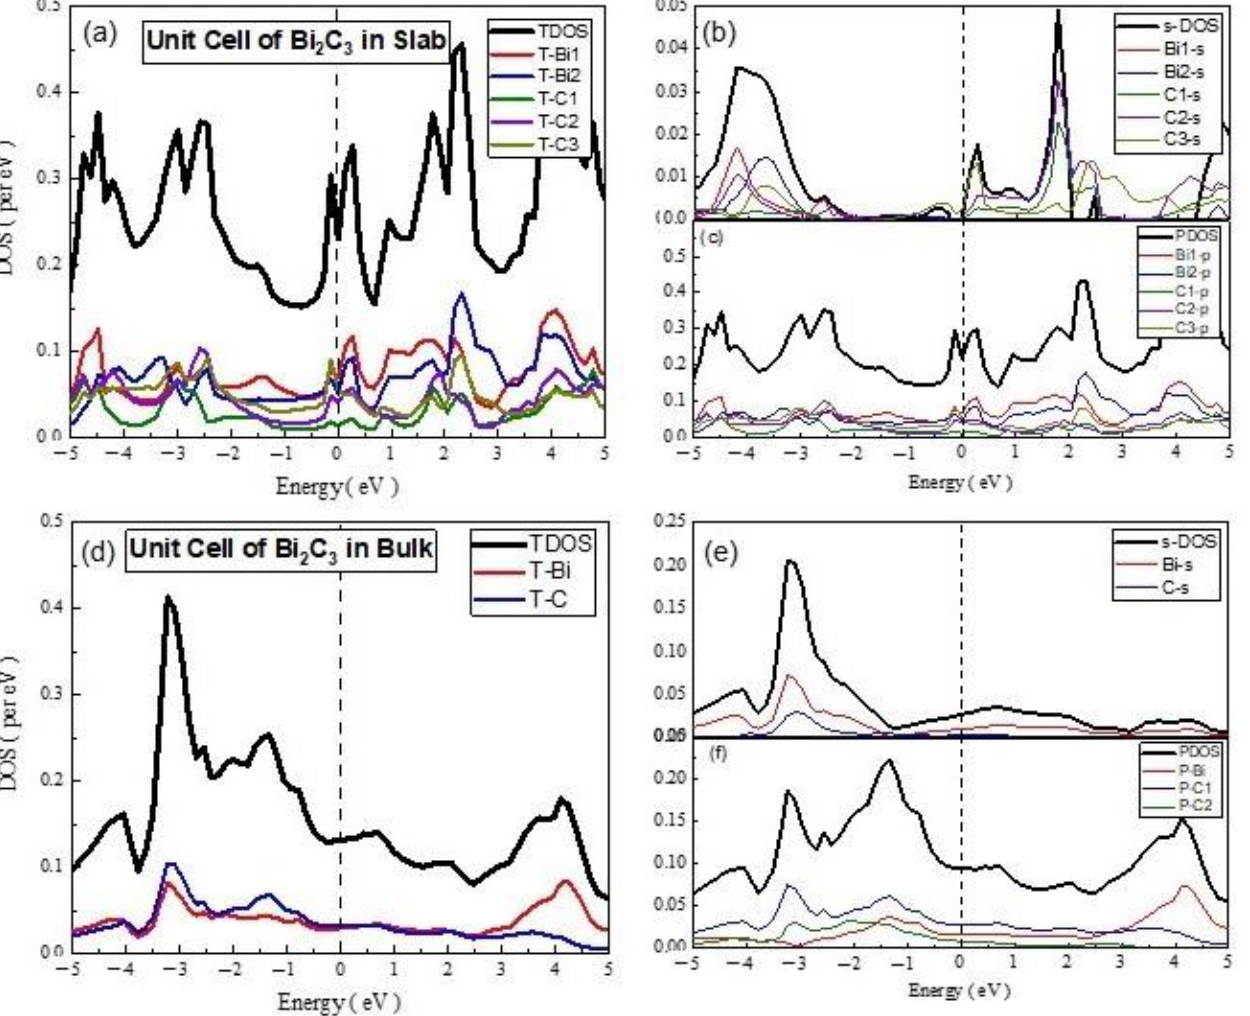
Figure 7. The calculated total density of states (TDOS) and partial density of states for mentioned atoms in Bi 2 C 3 unit cell ( a ) TDOS of slab ( b ) s-DOS of slab ( c ) p-DOS of slab ( d ) TDOS of bulk ( e ) s-DOS of bulk ( f ) p-DOS of bulk. The Fermi level was adjusted at 0 eV.